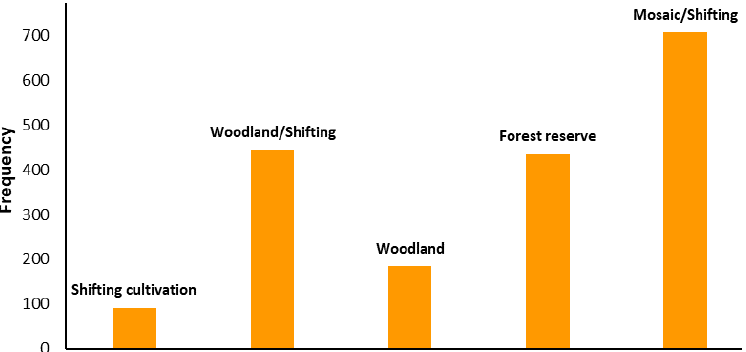
Figure 9. Browning trend for all three parameters for various land change dynamics.